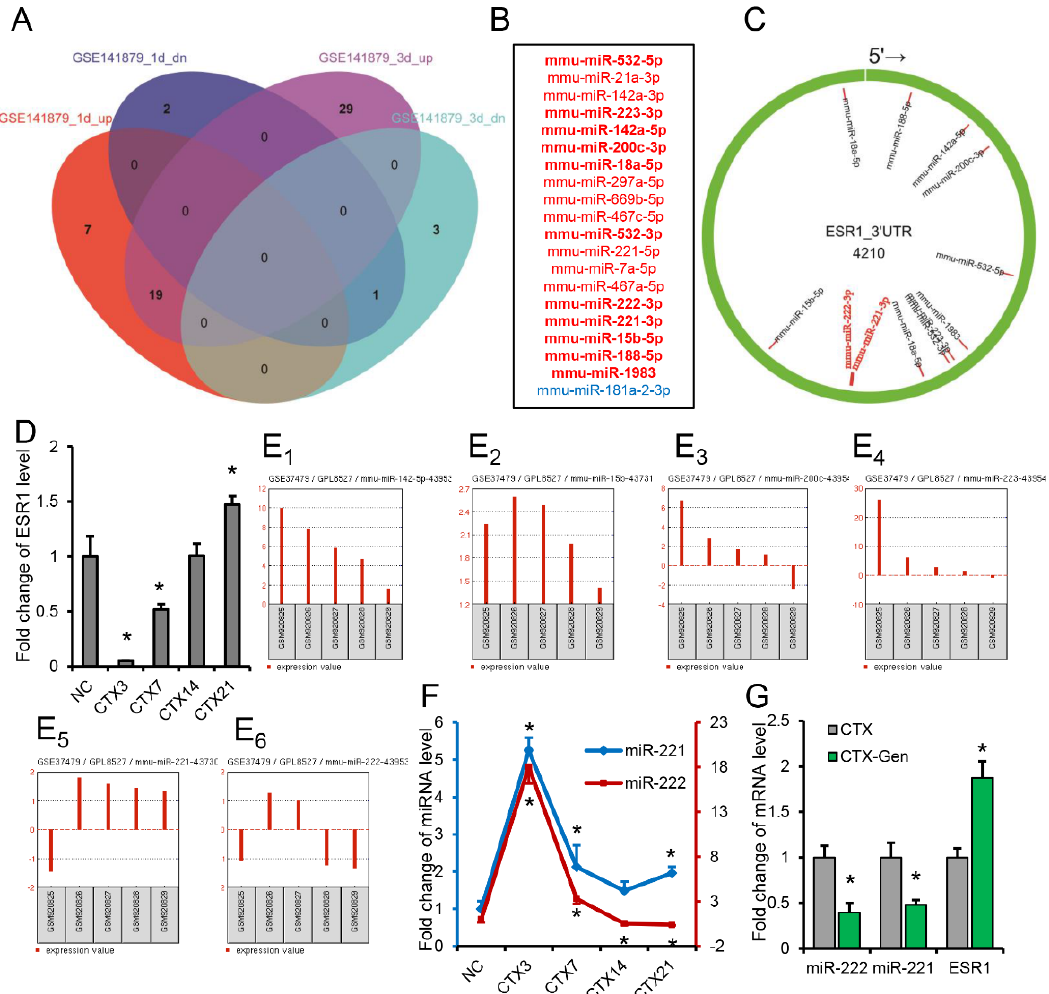
Figure 2. miR-221 and miR-222 are involved in skeletal muscle regeneration. ( A ) Venn diagram showing co-expression of miRNAs 1 day and 3 days after CTX injection (GSE141879). ( B ) Co-upregulated (red) and co-downregulated (blue) miRNAs. ( C ) Binding sites of co-upregulated miRNAs to the 3 (cid:48) UTR of ESR1 . ( D ) Expression of ESR1 during mouse skeletal muscle regeneration. ( E ) Expression of miR-142-5p ( E 1 ), miR-15b ( E 2 ), miR-200c ( E 3 ), miR-223 ( E 4 ), miR-221 ( E 5 ) and miR-222 ( E 6 ) during skeletal muscle regeneration in the GEO database (GSE37479, GSM920825 (day1), GSM920826 (day3), GSM920827 (day4), GSM920828 (day7), GSM920829 (day21)). ( F ) Expression of miR-221 and miR-222 during mouse skeletal muscle regeneration. ( G ) Expression of miR-221, miR-222 and ESR1 in TA muscle of no GEN-treated and GEN-treated mice at 21 days of injury. ( D , F , G ) n = 3. * p <